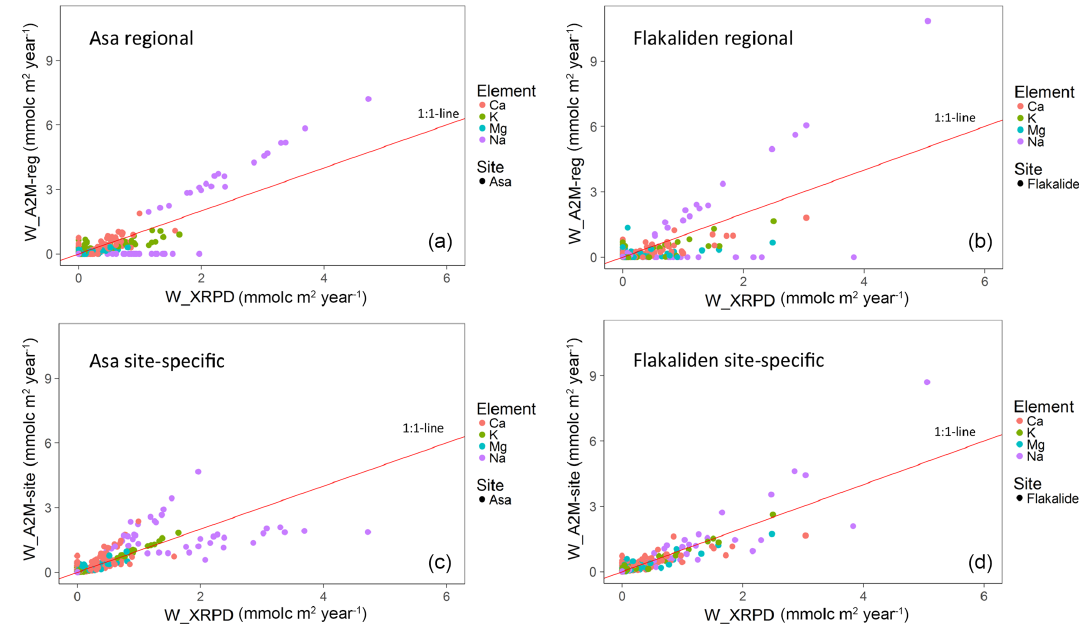
Figure 4. Comparison of PROFILE weathering rates based on XRPD mineralogy (mmol c m − 2 yr − 1 ) with PROFILE weathering rates based on regional A2M mineralogy (a, b) versus site-specific mineralogy (c, d) . Each data point represents a mean of 1000 PROFILE weathering rates for a specific soil depth of one of four soil profiles per